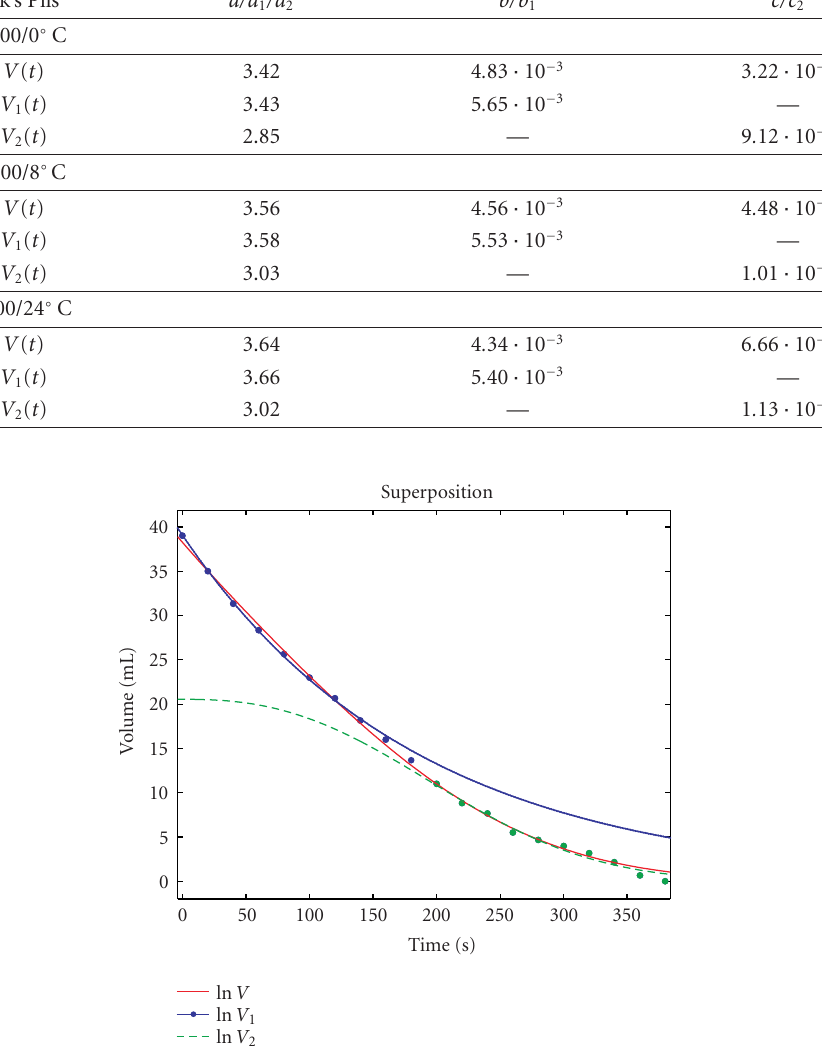
Figure 3.2. The foam volume as a function of time. The three di ff erent functions ln V , ln V 1 , and ln V 2 are put together in this figure for